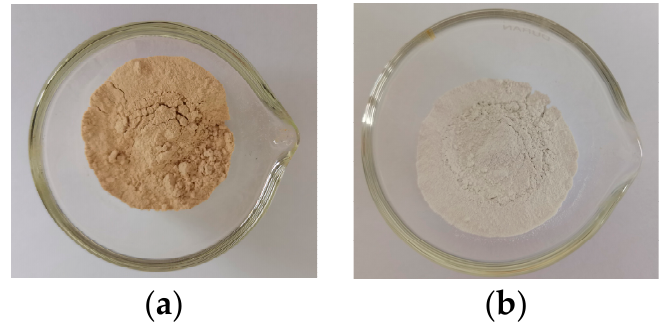
Figure 2. Images of ( a ) CP10VSW and ( b ) CP samples.